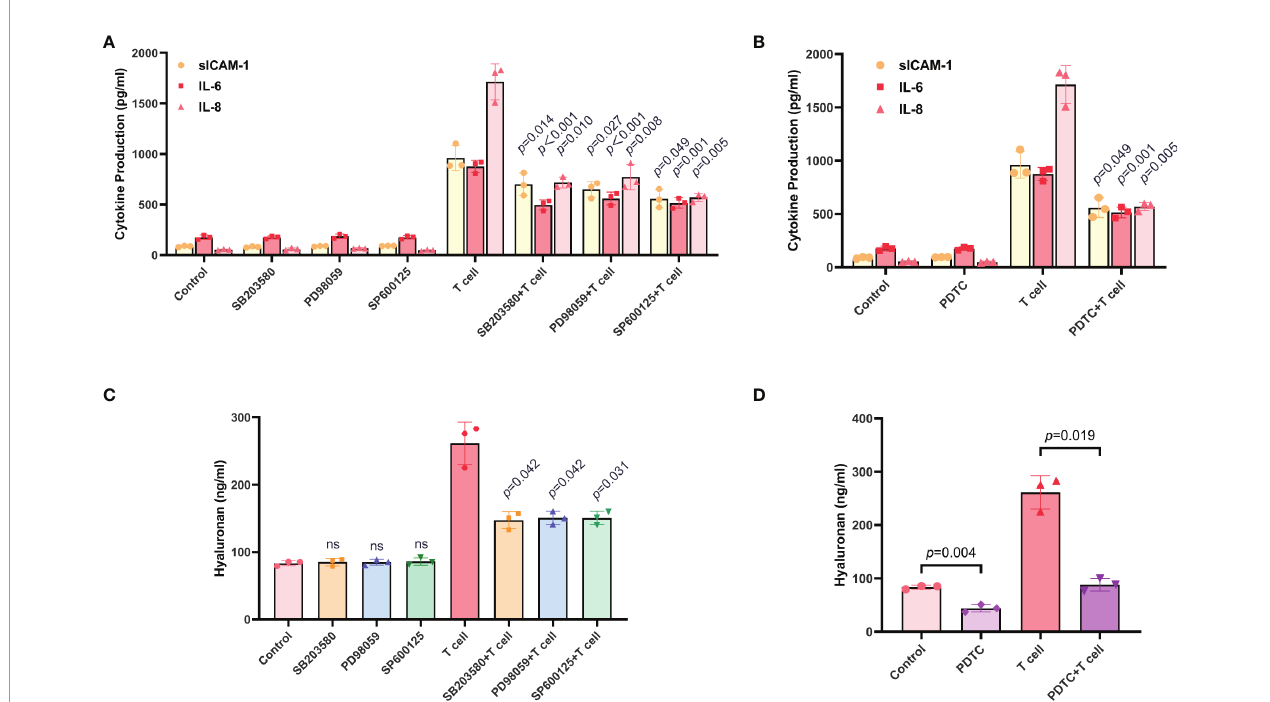
FIGURE 6 | The production of sICAM-1, IL-6, IL-8, and HA in TAO-OFs from the OF-T cell co-culture system were regulated by the MAPK and NF- k B signaling pathways. (A – D) TAO-OFs were treated with SB203580 (30 uM), PD98059 (30 uM), SP600125 (30 uM), and PDTC (100 uM) for 30 minutes, respectively, and then co-cultured with autologous T cells (OFs: T cells = 1: 10) for 24 hours or not. The supernatants were subjected to analysis of sICAM-1, IL-6, IL-8, (A, B) and HA (C, D) production by ELISA. Data are expressed as mean ± SD of triplicates. ns, no signi fi cance. Representative of three independent experiments using cells from a different